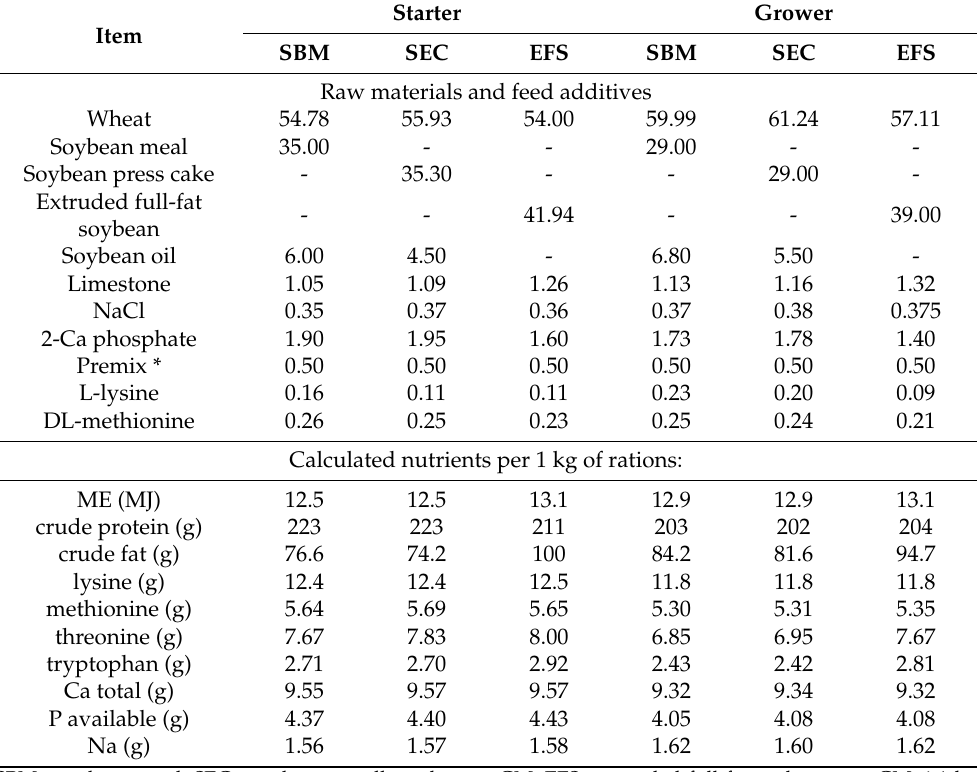
Table 2. Composition and nutritive value of Starter and Grower